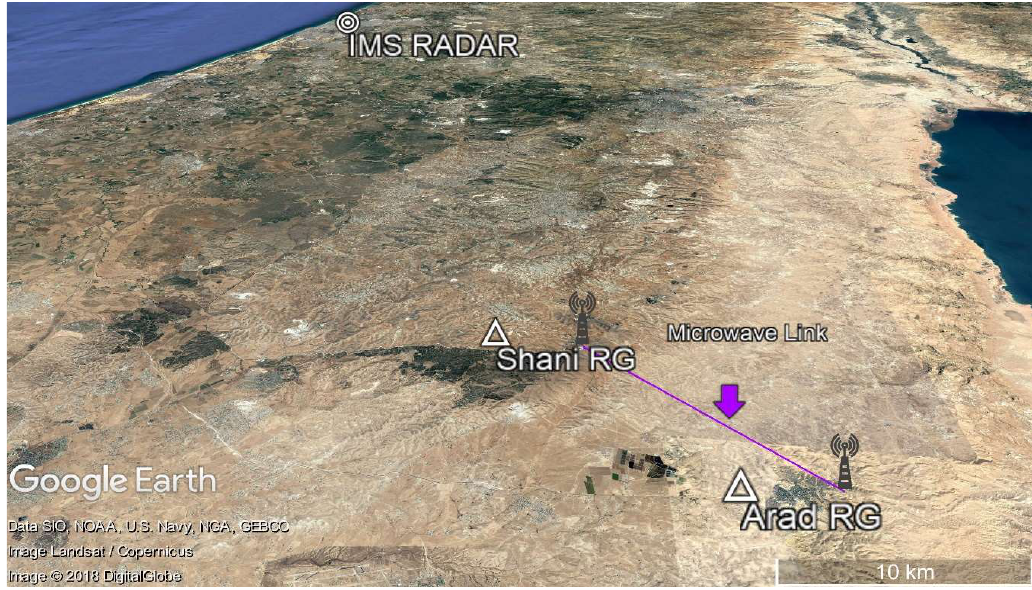
Figure 2. The experiment site area: Southern Israel, the weather radar of the Israeli Meteorological Service (IMS) (white target), Arad and Shani RGs (white triangles), and the commercial microwave link marked with two black antenna markers and the actual microwave link between them (purple).